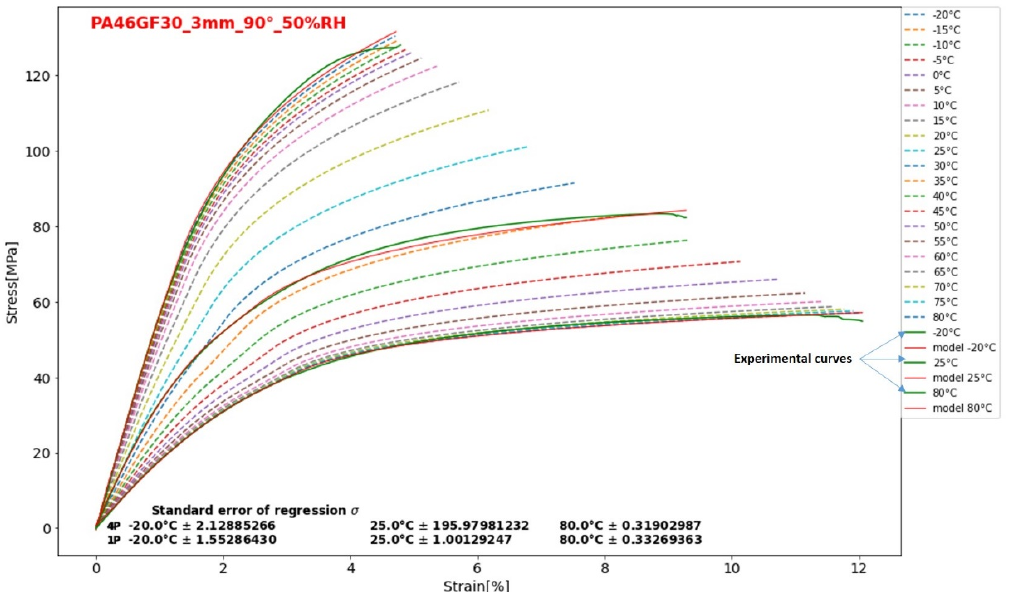
Figure 7. 4P stress–strain model, which provides the stress–strain graphs at any arbitrary fiber content, fiber orientation, and temperature 𝜎 = 𝑓(𝜀, 𝑡𝑒𝑚𝑝, 𝑓𝑐, 𝑓𝑜) . Results for PA46GF30, 3-mm-thickness, and 90° orientation are displayed as an example. Green curves are experimental curves, red lines are model data with the 1P model, and dotted colorful data are 4P model with four independent parameters.